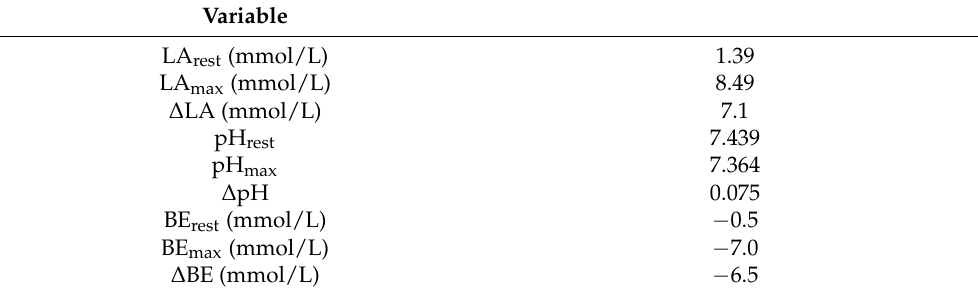
Table 7. Changes in blood lactate concentration and values in selected variables of acid-base balance during CPET performed before the competition.